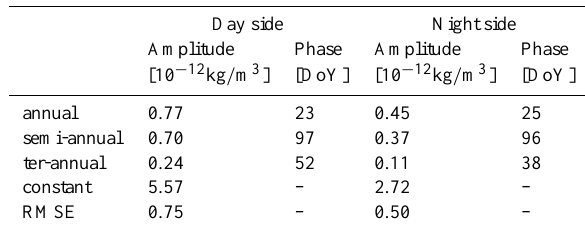
Table 1. Coefficients of the harmonic seasonal variation functions. certainty within a 95% confidence is about ± 2 . 4 × 10 − 14 kg / m 3 and ± 1 . 6 × 10 − 14 kg / m 3 for the amplitude of all the harmonics on the day and night side, respectively. The uncertainty of the phases (day of peak amplitude) is about ±